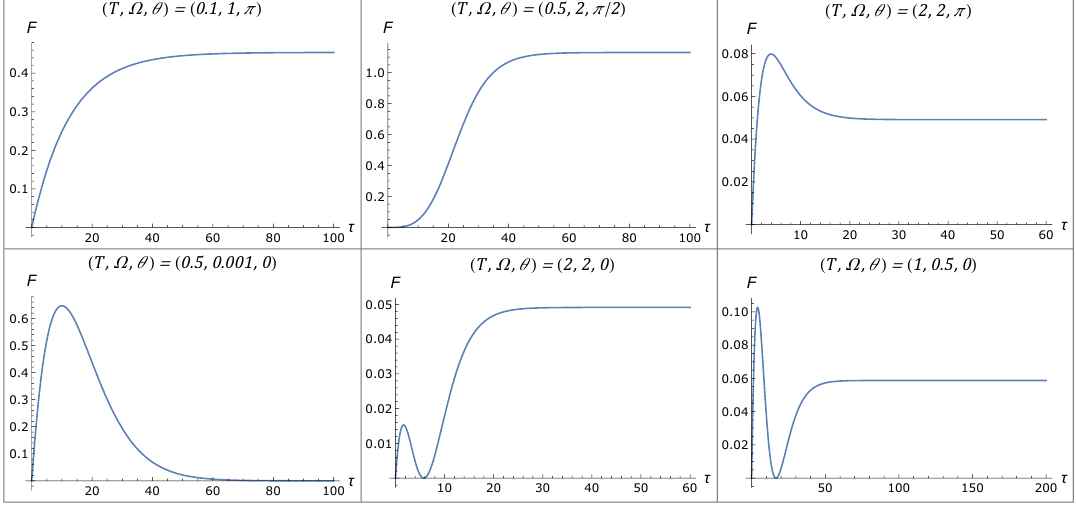
accelerations for a variety of ( T, Ω , θ ) values. Graphs in the same row share the same ( T, Ω) values, starting with ( T, Ω) = (1 , 1) in the second row, with T increasing below and Ω increasing above. Each column corresponds to a different initial state: on the left, θ = 0 corresponds to the ground state | 0 i ; on the right, θ = π corresponds to the excited state | 1 i ; in the middle, θ = π/ 2 corresponds to an equal superposition of ground and excited √ states ( | 0 i + | 1 i ) / 2